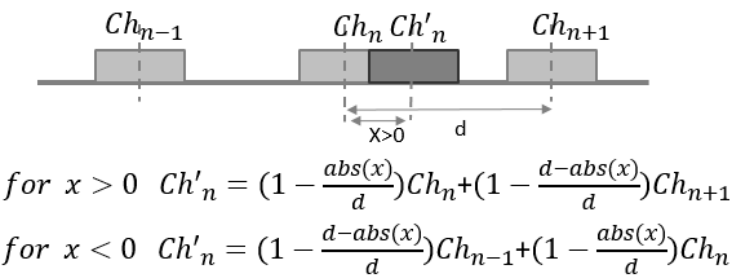
Figure 7. Linear interpolation for simulating new EMG channels: Depending on the direction of the electrode displacement, relevant neighboring channels were used. New artificial EMG data were estimated by linearly summing up data of neighboring channels multiplied with factors that are reverse proportional to distances, as proposed in recent studies (see